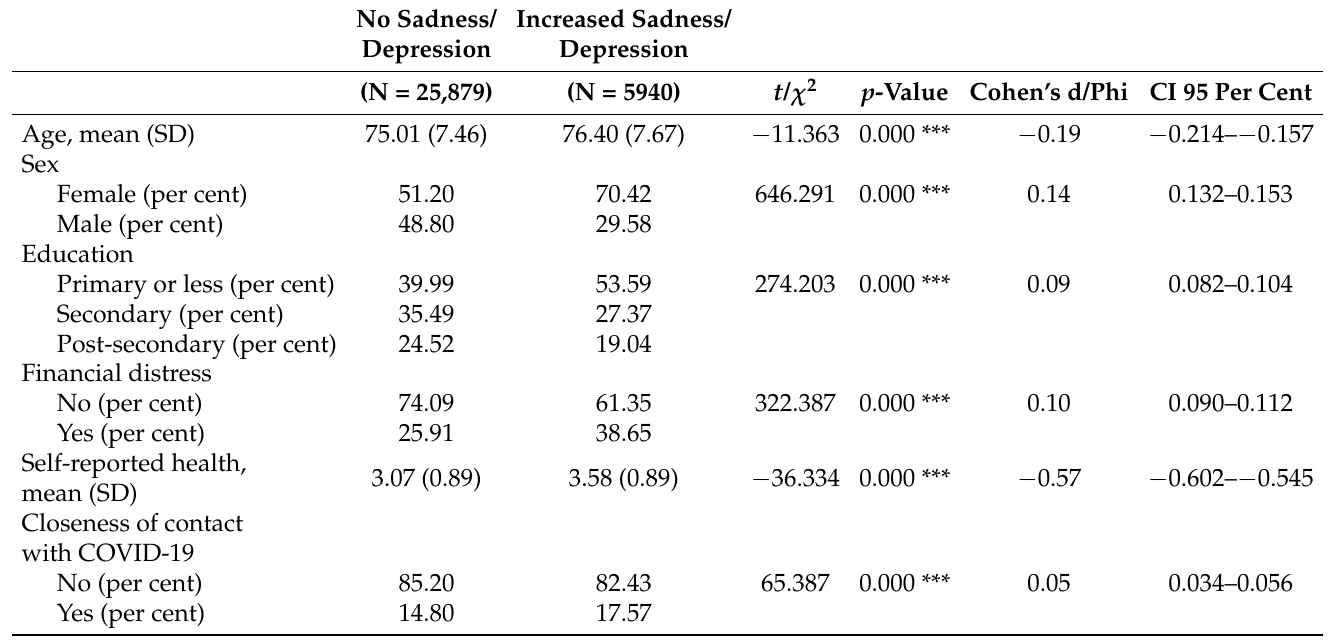
Table 1. Characteristics of the no sadness/depression group and the increased sadness/depression